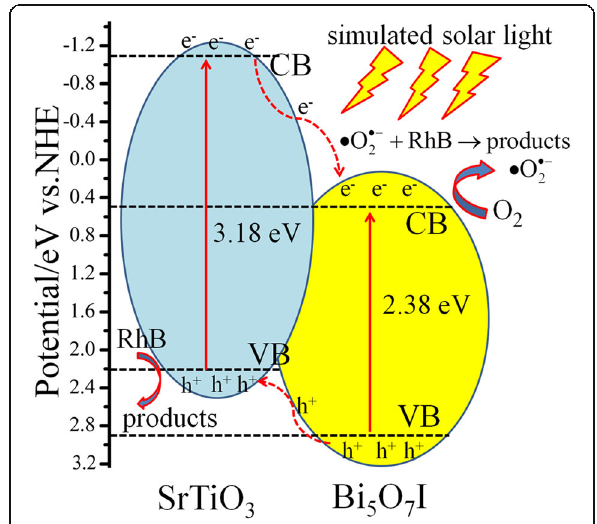
Fig. 9 The schematic energy band diagram and